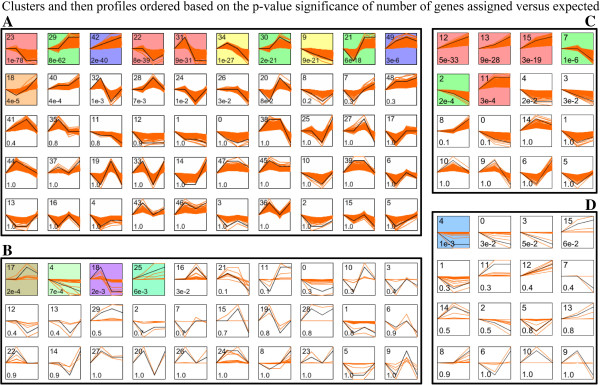
Short Time-series Expression Miner clusters of expression profiles. The profiles ordered based on the p-value significance of number (at bottom-left corner) of genes or miRNAs assigned versus expected. Colour square frame denote significant profiles (P-value ≤ 0.01). Each graph displays the mean pattern of expression (black lines) of the profile genes. The number of profiles in each cluster is at the top left corner of each STEM. A and B represent the development-specific mRNA and miRNA profiles, respectively. C and D represent the internode-specific mRNA and miRNA profiles, respectively. The x-axis represents time (development-specific or internode-specific stages) and the y-axis represents log2 fold change of gene expression.